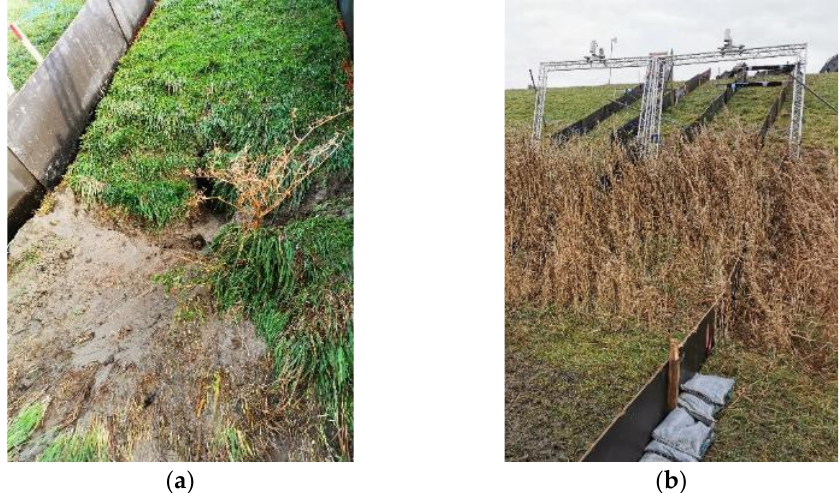
Figure 8. ( a ) Burrow entrance halfway the landside slope on a Dutch dike; ( b ) Sections with softened, saturated soil and reed overgrowth on a Dutch dike.